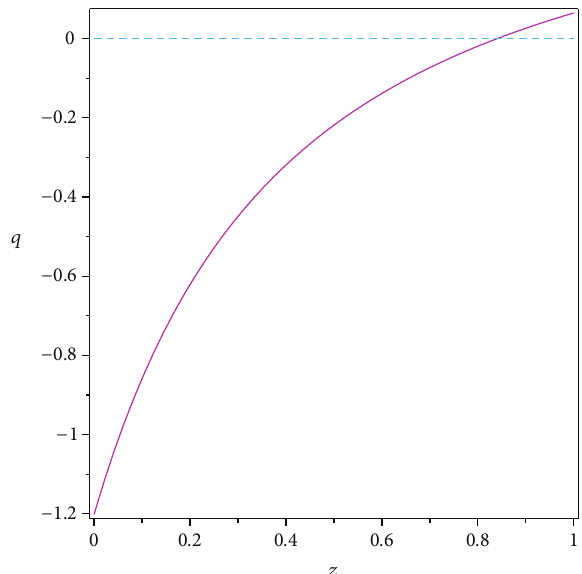
Figure 8: The evolution of the deceleration parameter of the hybrid chameleon model versus the red-shift for the case that 𝑚 = 1.2 , 𝑛 = 0.7 , 𝛽 = 1 , and 𝜔 = 0